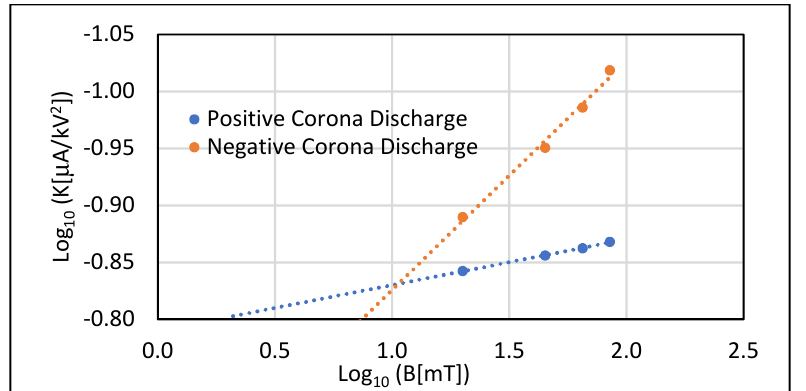
Figure 15. The geometrical factor K versus the crossed magnetic field on log 10 scale for both discharge polarities.